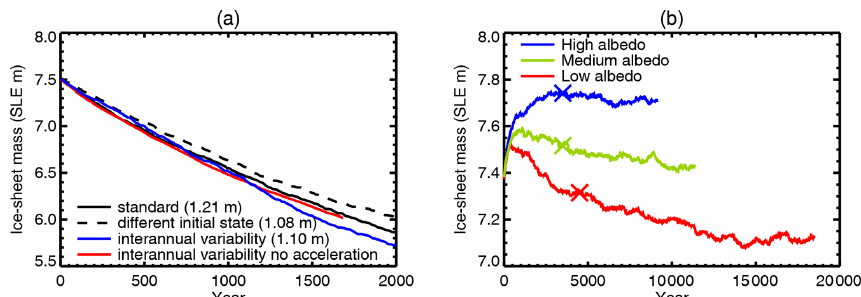
Figure A1. (a) Time series of Greenland ice sheet mass for the first 2000 ice sheet years in experiments with CanESM2 RCP8.5 2081–2100 climate and FAMOUS–ice medium albedo as an example of sensitivity to technical modifications: different AGCM initial state, individual monthly means for the sea surface BCs (“interannual variability”) rather than climatological monthly means and synchronous coupling (one ice sheet year per climate year, “no acceleration”) rather than 10 : 1 acceleration. The numbers in parentheses give the final steady-state mass. (b) Time series of Greenland ice sheet mass with constant climate for 1980–1999 simulated by MIROC5 during FiG spin-up integrations beginning from the observed topography (Bamber et al., 2001a, b). The crosses indicate the states from which the experiments of Sect. 3 were